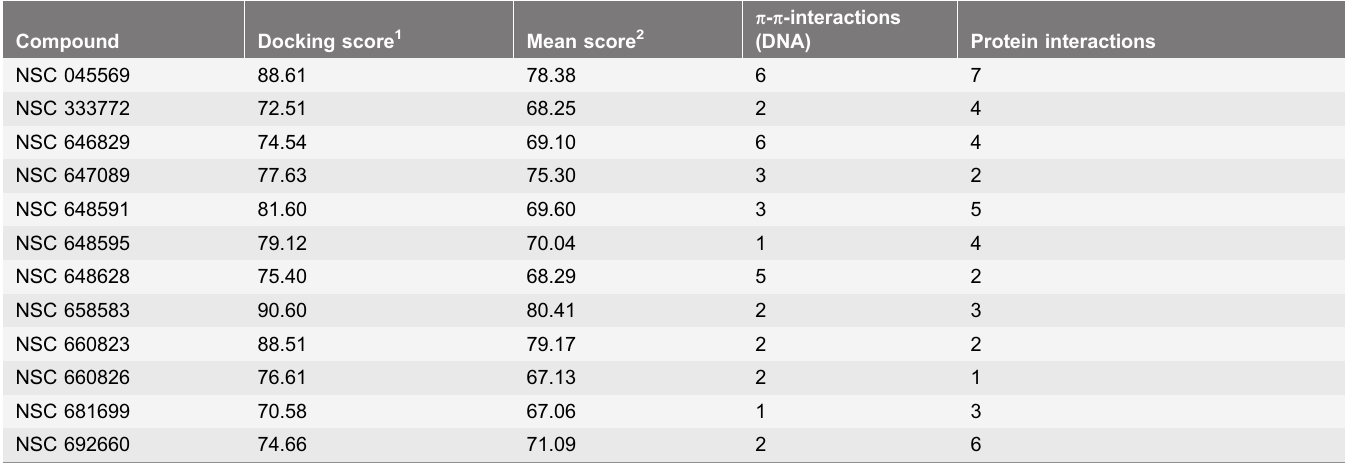
Table 1. Compounds suggested from Top2 a docking studies. Compound Docking score 1 Mean score 2